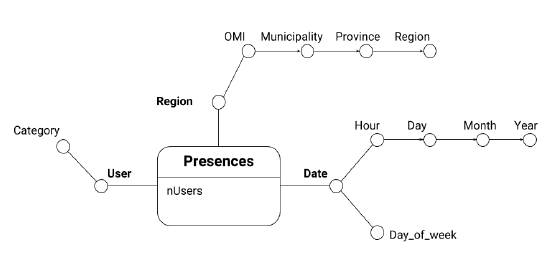
Figure 2. Data Warehouse Design.